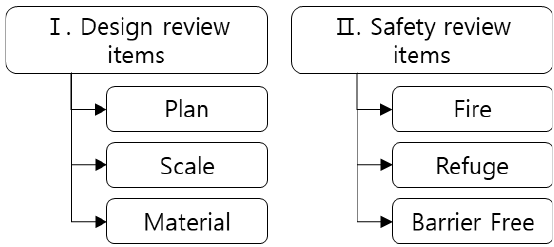
Figure 3. Design checklist items. Table 2. Codes for design review items.